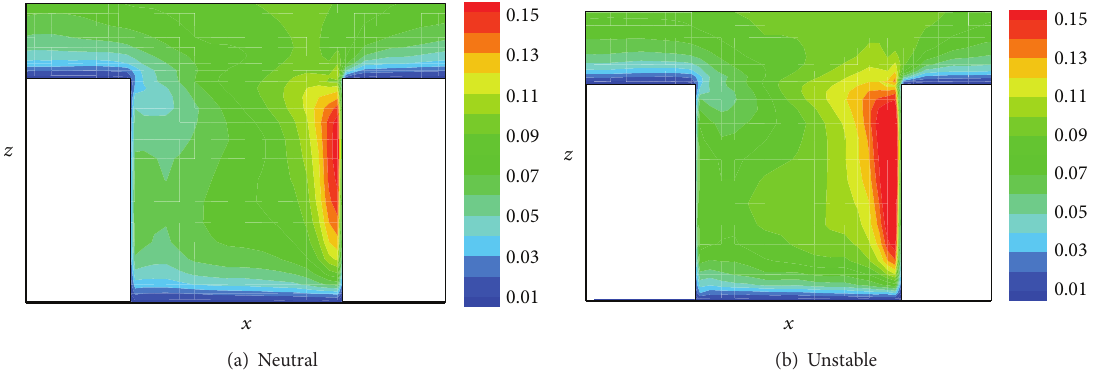
Figure 8: Contours of vertical turbulence intensity 𝑤